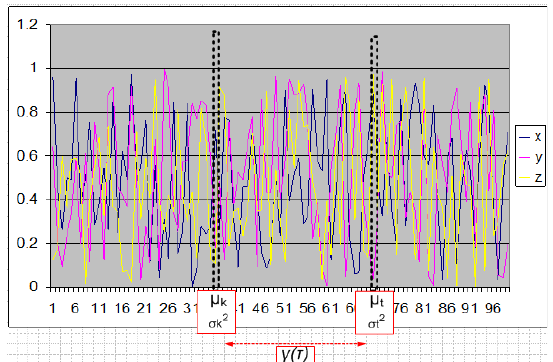
Figure 5. Depiction of an arbitrary Weakly stationary time-series traces ( X,Y,Z ) all generated from a stochastic process whose statistical properties are time invariant between various runs: implying the means ( µ k , µ t ) and variances ( σ 2 , σ 2 ) are finite and relatively constant over various time slices. t k Moreover, auto-covariance ( γ ( τ )) between various time slices is finite and is only a function of temporal distance τ = | t − k |